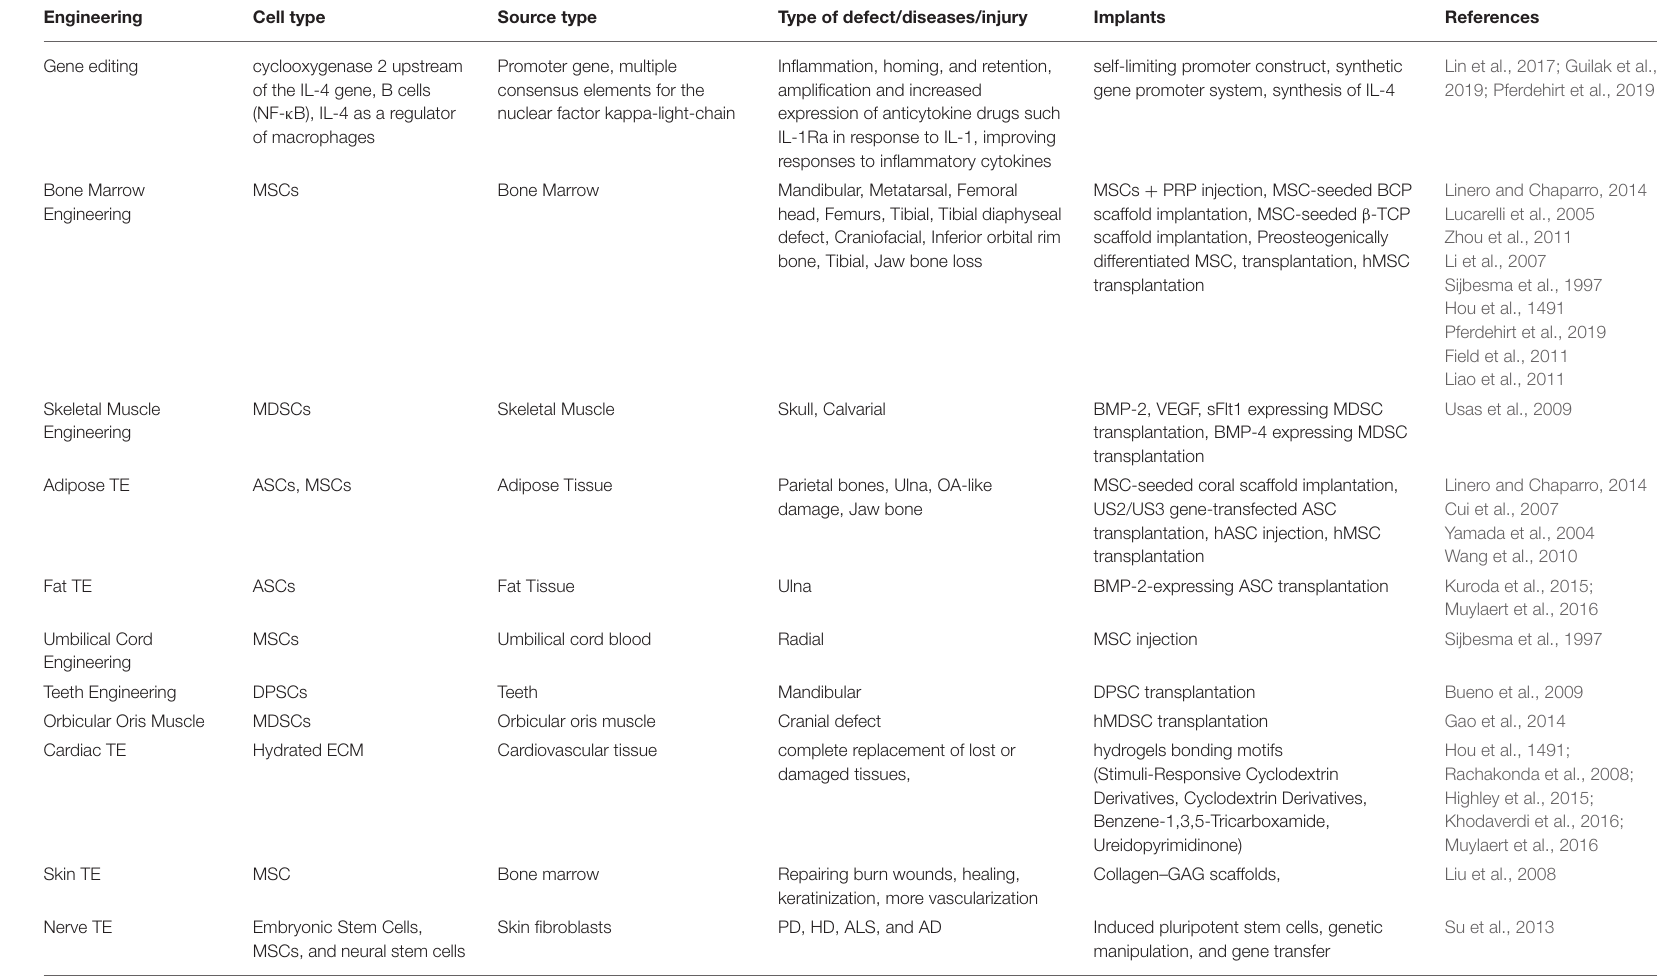
TABLE 1 | Various types of stem cells are utilized in treating defects and increasing tissue repair and regeneration for different cell